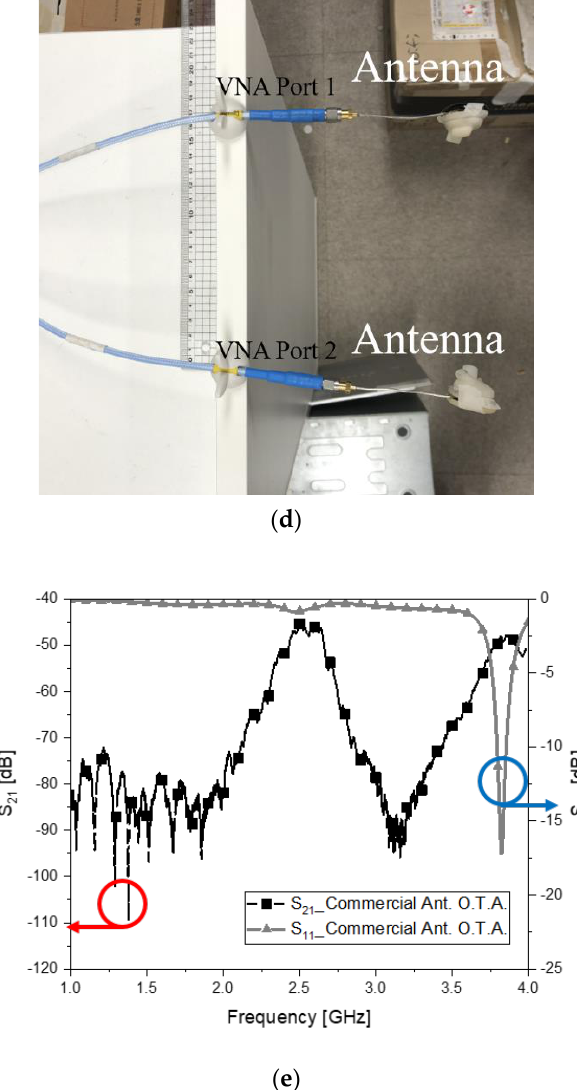
Figure 6. Antennas in the earphones and link test. ( a ) Proposed antennas (left) and commercial antennas (right); ( b ) direct link of the proposed antennas; ( c ) s-parameter of the proposed antennas; ( d ) direct link of the commercial antennas; ( e ) s-parameter of the commercial antennas.